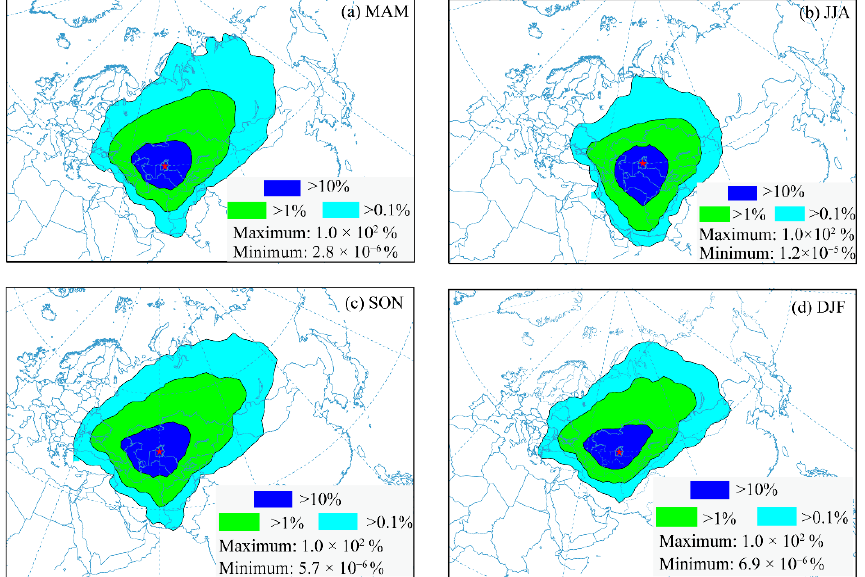
Figure 11. Zone most frequently impacted by aerosols from the Aral Sea region in different seasons. The red asterisk indicates the location of the Aral Sea.